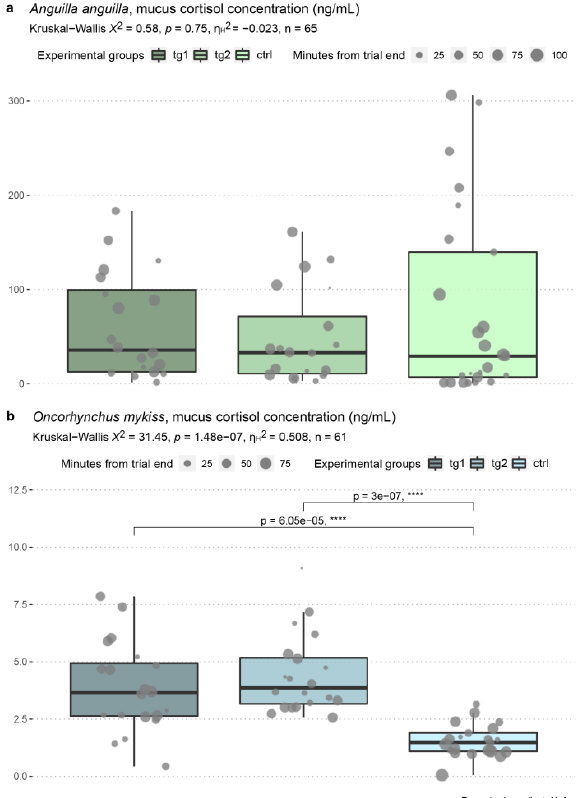
Figure 3. Concentrations of skin mucus cortisol (ng mL − 1 ) quantified in A. anguilla ( a ) and O. mykiss ( b ), with details of the statistical analyses. Experimental groups are color coded, and points overlaid on box-plots reflect time in minutes elapsed from the end of trial to sampling operations. Post hoc testing was performed only in case the main effect was statistically significant ( p < 0.05). η H2 : eta squared based on the H-statistic; pwc: pairwise comparison; asterisks denote degree of statistical